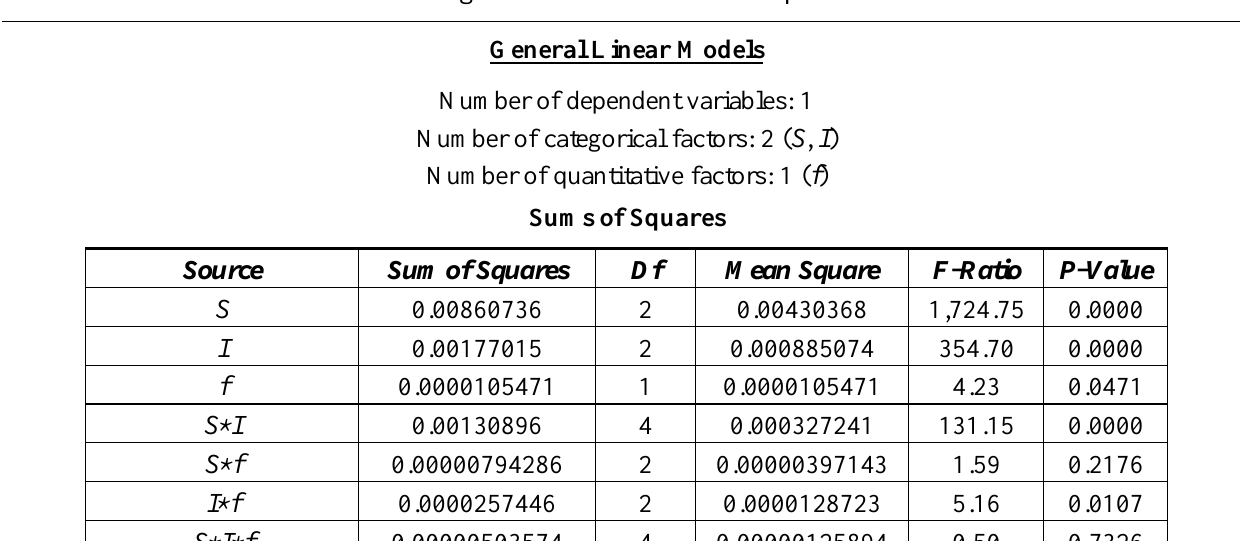
Table 7. Resulting ANOVA table of the temporal trend model.